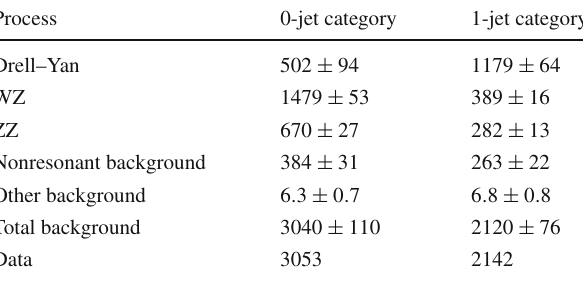
Table 3 Observed number of events and post-fit background estimates in the two jet multiplicity categories of the SR. The reported uncer- tainty represents the sum in quadrature of the statistical and systematic components